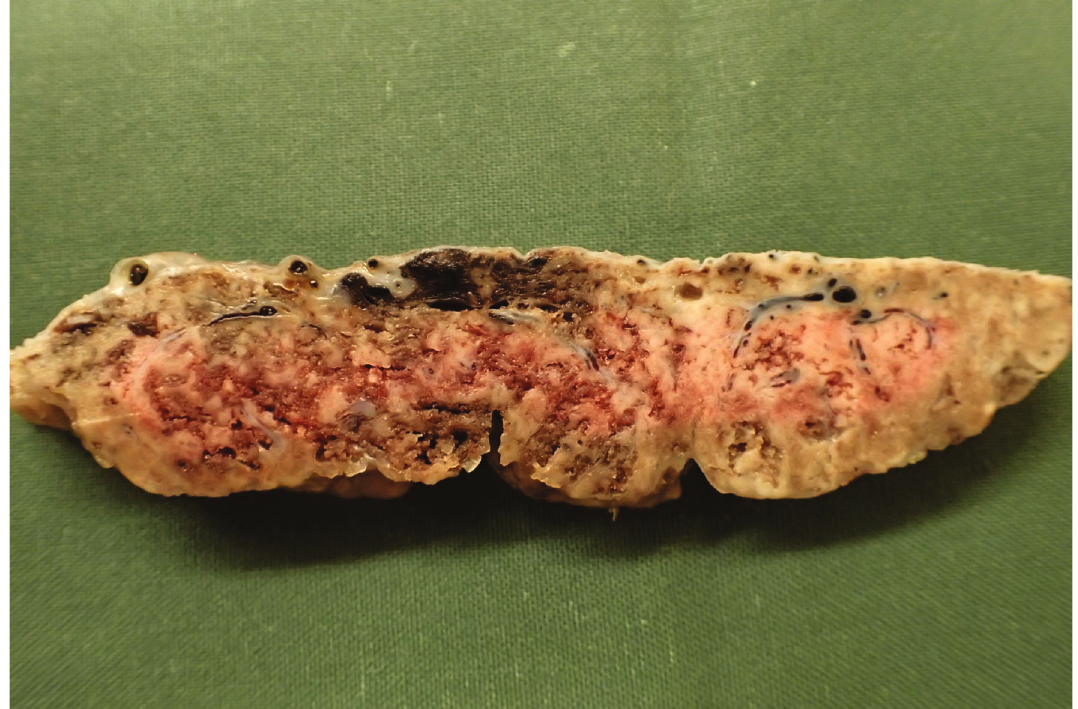
Figure 6: Placenta with sign of massive perivillous fi brin deposition. Placenta from Case